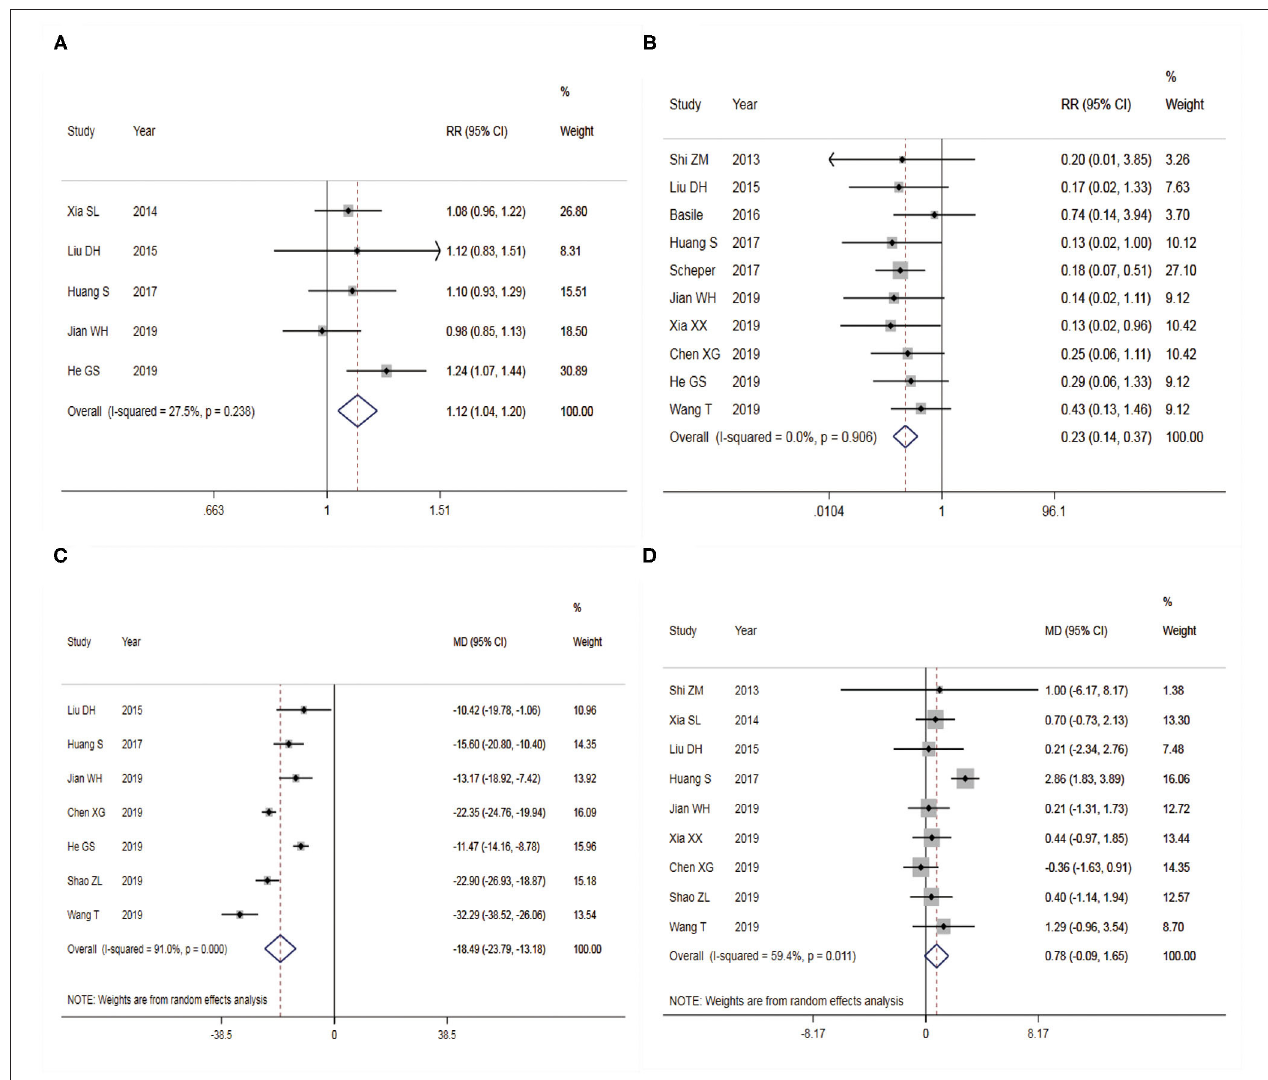
FIGURE 3 | Forest plots of two surgical procedures with associated outcome indicators ( A : excellent and good rate of Maryland foot function; B : postoperative complications; C : intraoperative blood loss; D : Böhler angle). Left side of the X-axis favors the Sinus tarsal approach; right side of the X-axis favors the conventional L-shaped lateral approach. RR, relative ratio; MD, mean difference. Red dotted line shows the pooled effect